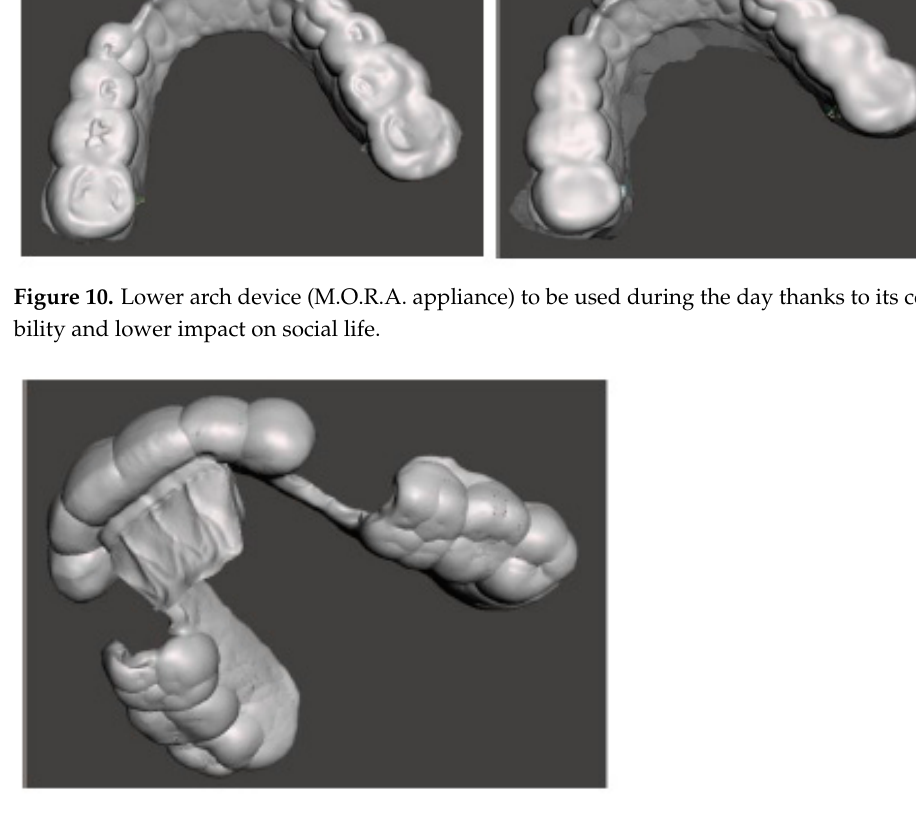
Figure 11. Upper arch device to be used during the night with a design that allows it to maintain a therapeutic position during sleep.